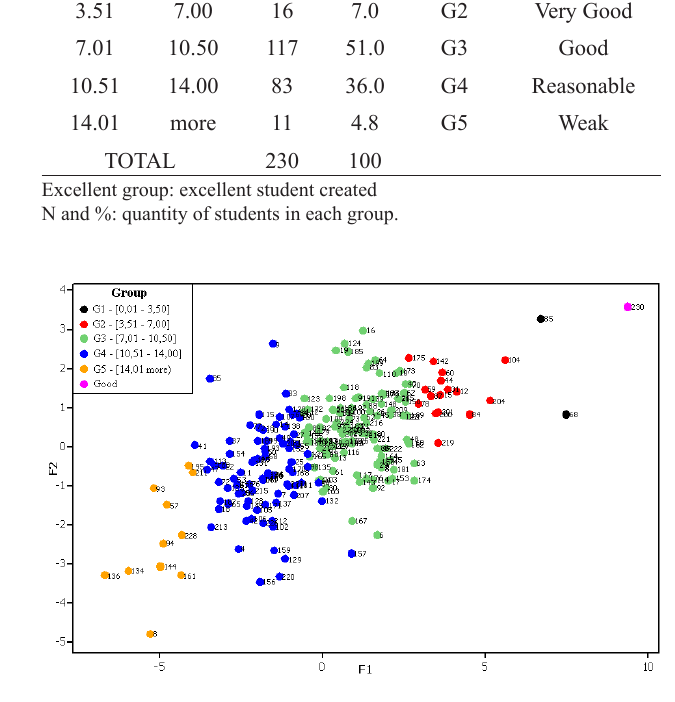
Figure 2. Dispersion graph according to the male group.